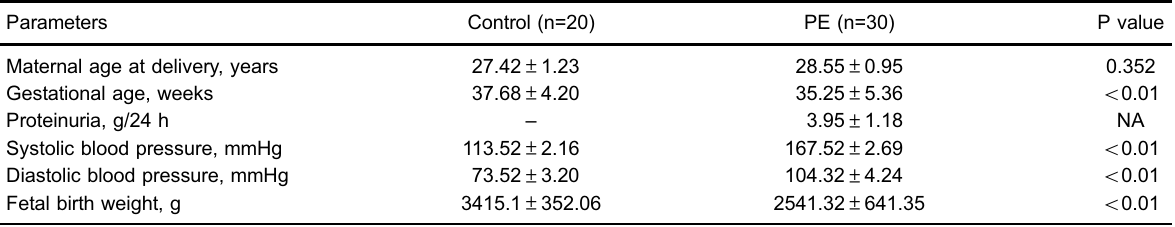
Table 1. Clinical characteristics of preeclampsia (PE) patients and normal pregnant women.